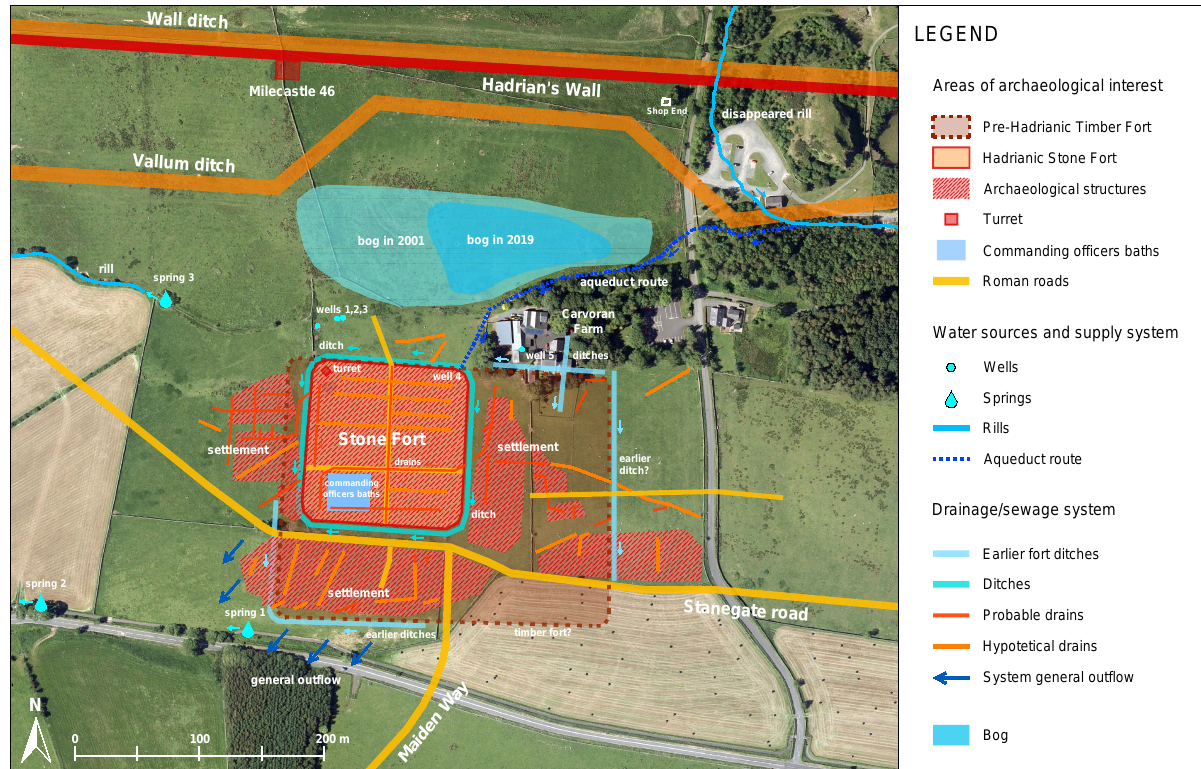
Figure 4. Map of Magna showing the archaeological features and hydraulic systems layouts. The background is a 2018 drone image, courtesy of the Vindolanda Trust. The proposed vector graphic layout plan is the result of the analysis and comparison of all the actual available data (historical data and recent surveys), showing the archaeological structure predictions (roads, buildings, bath) as well as the features of the hydraulic systems, with the available water sources (wells, springs, rills), the aqueduct likely course and origin, the drainage and sewage systems (ditches and sewers) and the general water outflow of the